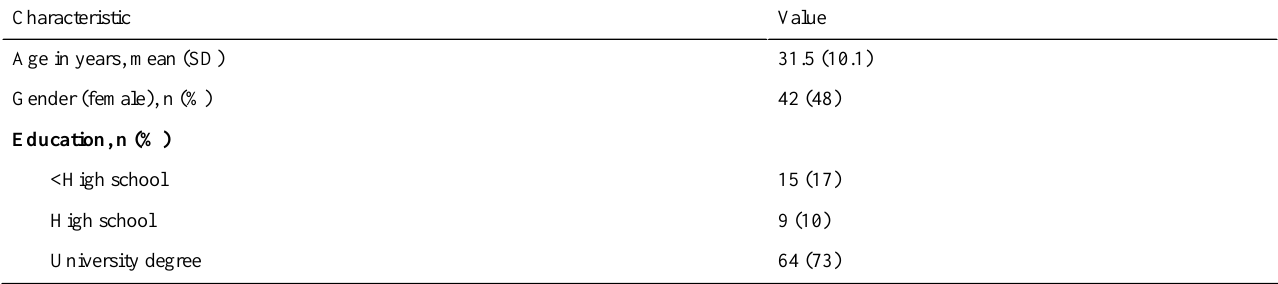
Table 2. Demographic characteristics of participants (n=88).